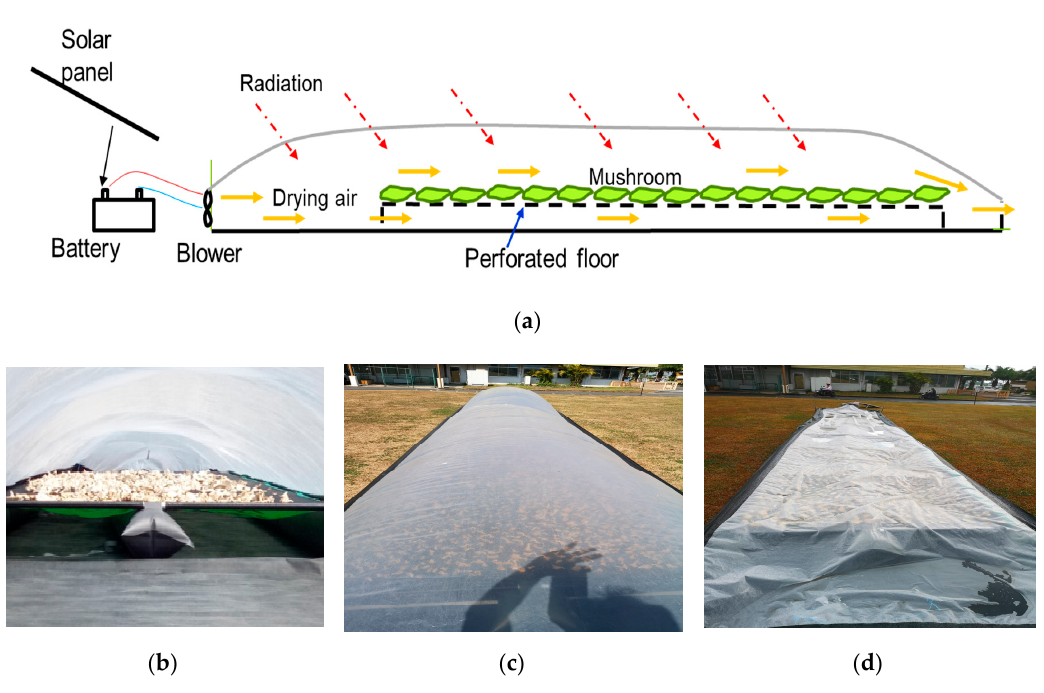
Figure 3. ( a ). Schematic diagram of the modified SBD for mushroom drying; ( b ). Perforated floor (bubble dryer bed) and oyster mushroom inside the SBD; ( c ). The SBD during drying (day time); ( d ). The SBD during non-working time (night).